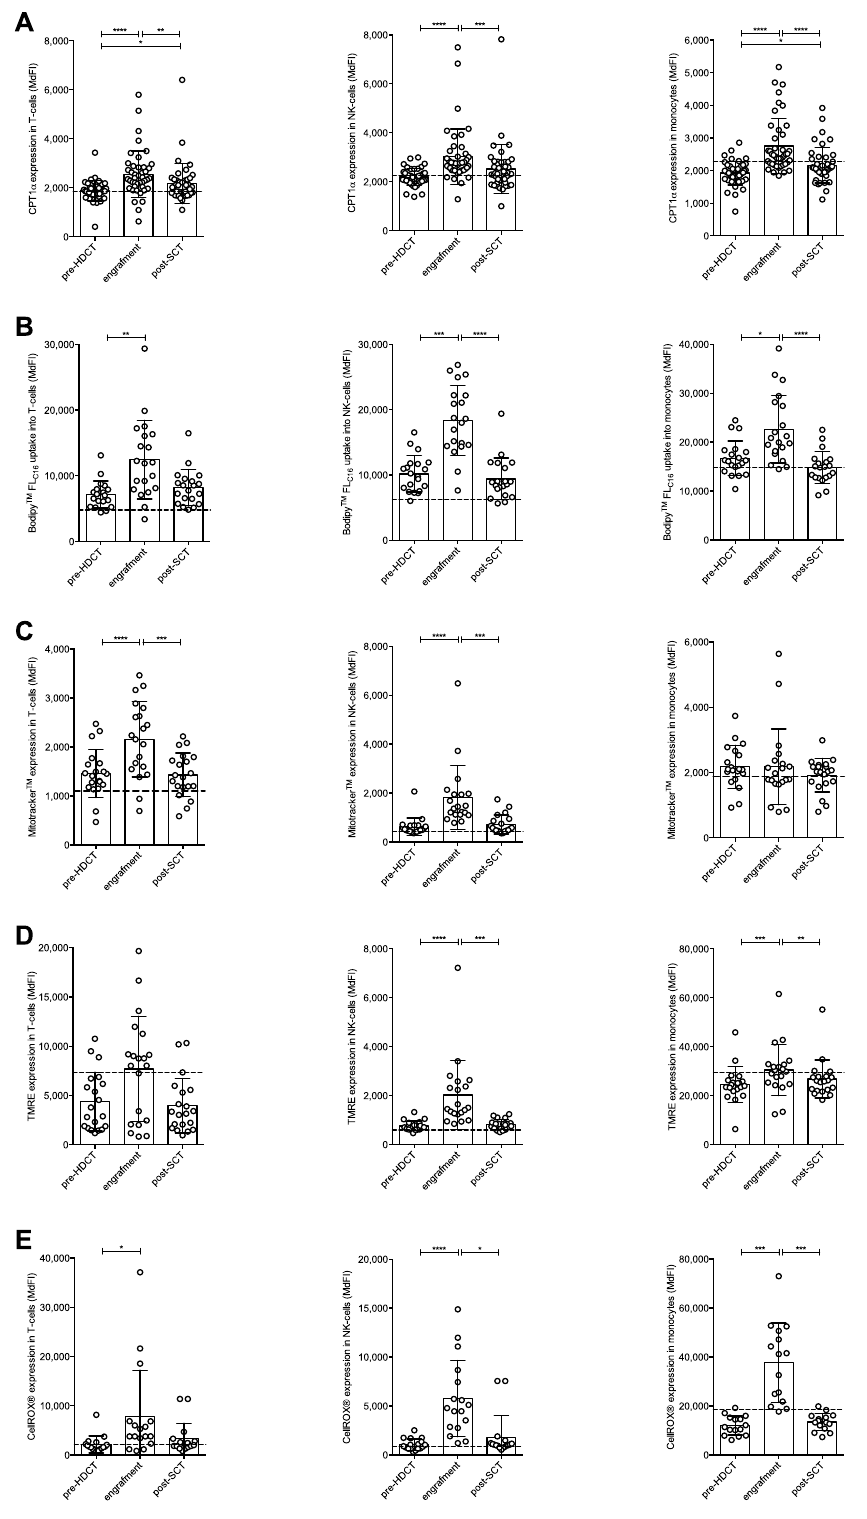
Figure 4. FAO and mitochondrial parameters are increased in T-cells, NK-cells, and monocytes upon HDCT/auto-SCT. ( A ) The FAO pathway was analyzed by measuring the expression of CPT1α. ( B ) Uptake of fatty acids was measured using the fluorescent fatty acid analogue Bodipy FL C16 . ( C ) Mitochondrial mass was measured using Mitotracker. ( D ) Mitochondrial membrane potential was measured using TMRE. ( E ) Cellular ROS production was evaluated using CellROX Deep Red reagent. All results were plotted as median fluorescence intensity (MdFI) for all cell populations (n: 15–43, mean values +/− SD). The mean of a healthy donor control group (n: 10–19) is shown as a horizontal dashed line for reference. Statistical significance was determined using a Friedman test with Dunn’s multiple comparison tests for repeated measurements. *P < .05; **P < .01; ***P < .001; ****P <